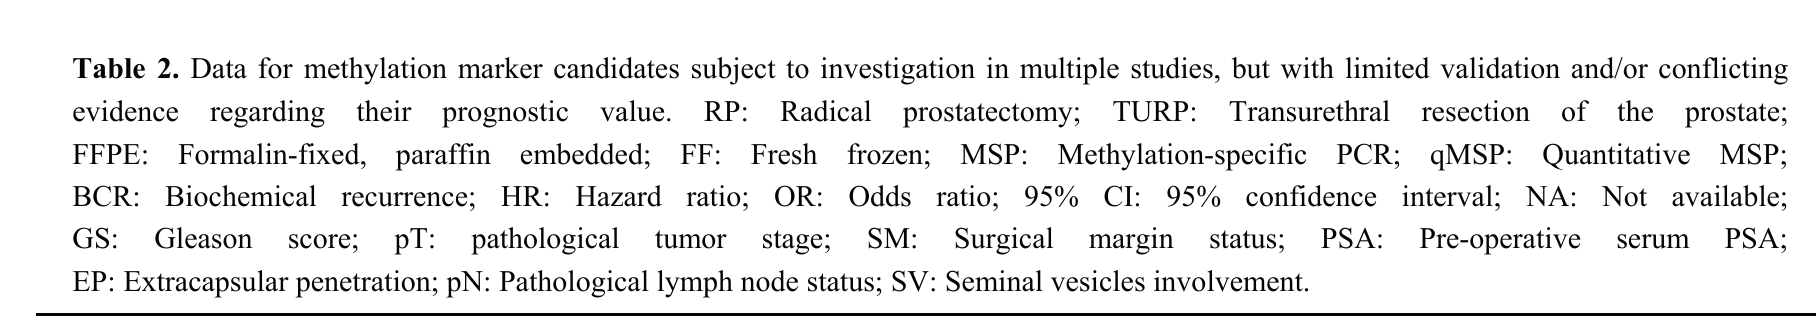
Table 2. Data for methylation marker candidates subject to investigation in multiple studies, but with limited validation and/or conflicting